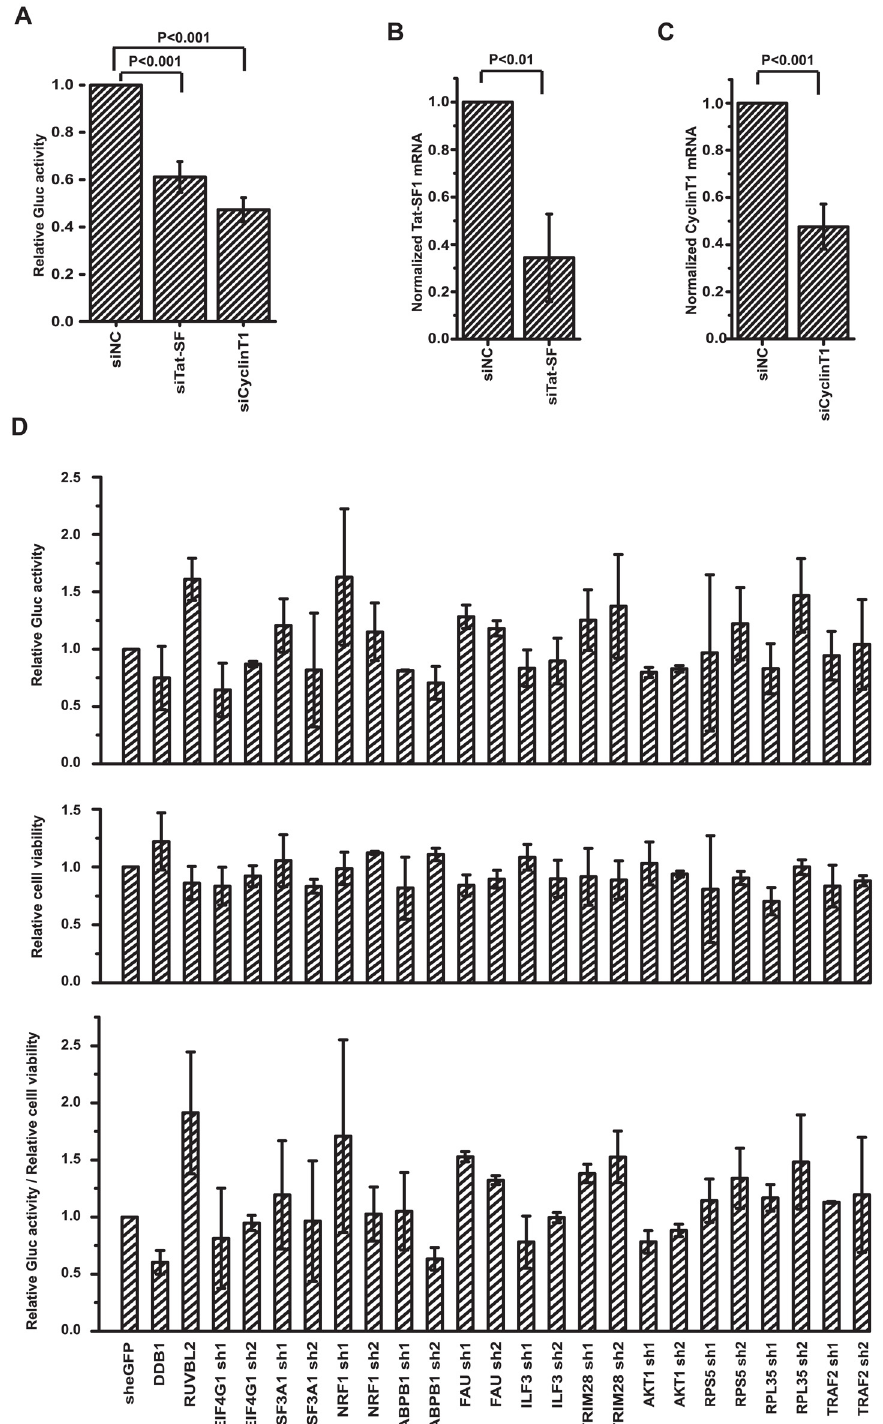
Fig 4. Effect of host factors knockdown on Gluc expression in A549-5Ps cells. A549-5Ps cells were transfected with 10nM negative control siRNA (NC), Tat-SF1 siRNA and cyclinT1 siRNA, respectively. (A) Gluc activity in supernatants was quantified. (B and C) Total cellular RNAs were extracted to quantify mRNA level of Tat-SF1 and cyclinT1 by real-time RT-PCR. Error bars standard error of the mean of four independent experiments. (D) A549-5Ps cells were transducted with shRNAs targeting candidate genes as indicated.